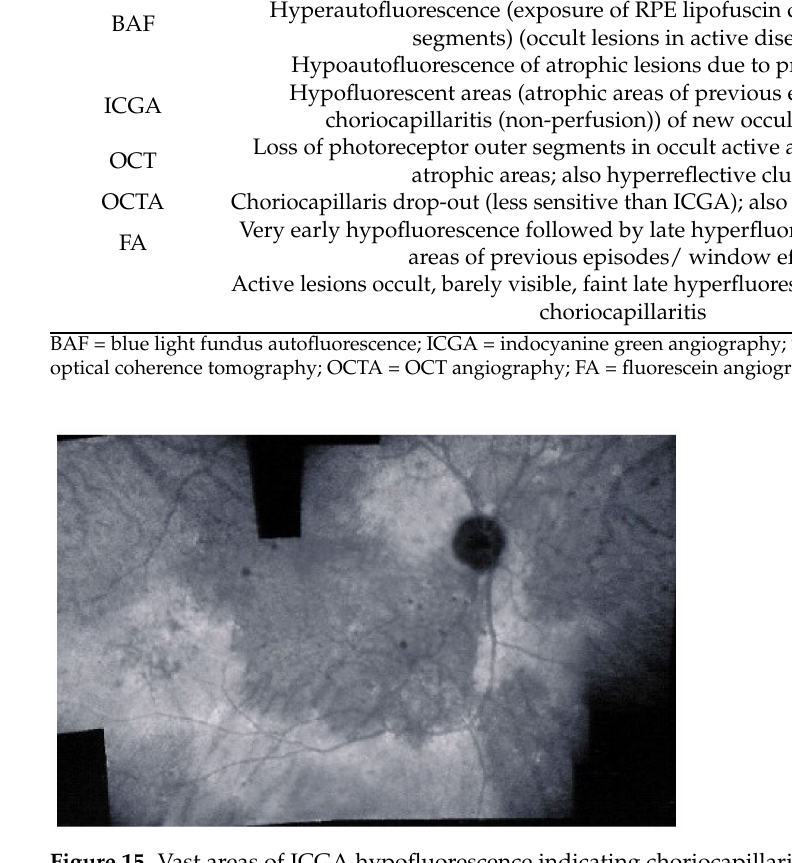
Figure 15. Vast areas of ICGA hypofluorescence indicating choriocapillaris hypo or nonperfusion surrounding the disc. These areas indicate that in some cases, the inflammatory process going on sub-clinically is involving vast areas of choriocapillaris perfusion problems and can be a trigger for the development of